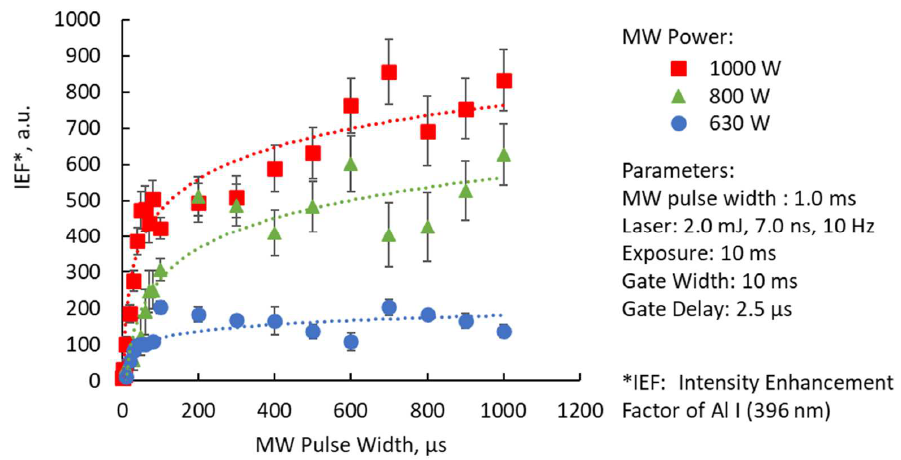
Figure 11. Enhancement factors for various microwave input peak powers.